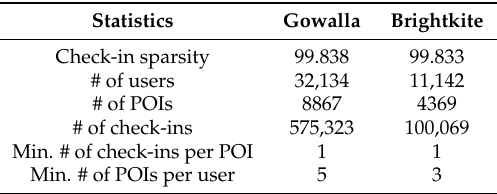
Table 2. Statistics of the Brightkite and Gowalla